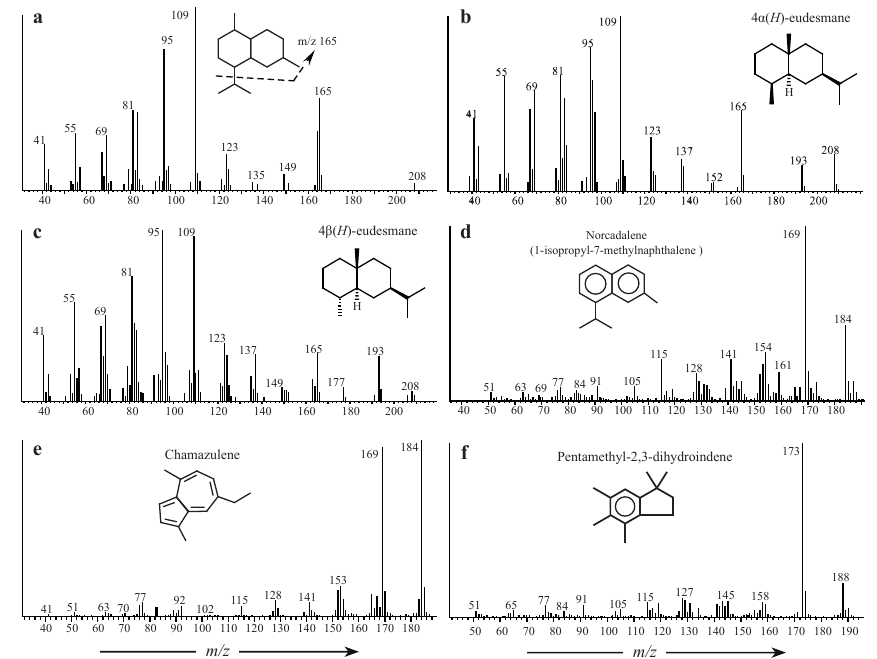
Fig. 4. Mass spectra of some identified Araucariaceae sesquiterpenoids. (a) : saturated cadalane-type compounds; (b) : 4 α (H)-eudesmane (identified using Wiley275 database); (c) : 4 β (H)-eudesmane (identified from spectrum in Alexander et al., 1983); (d) : norcadalene (identified from spectrum in Singh et al., 1994); (e) : chamazulene (identified using Wiley275 database); (f) : pentamethyl-2,3-dihydroindene (identified using Wiley275